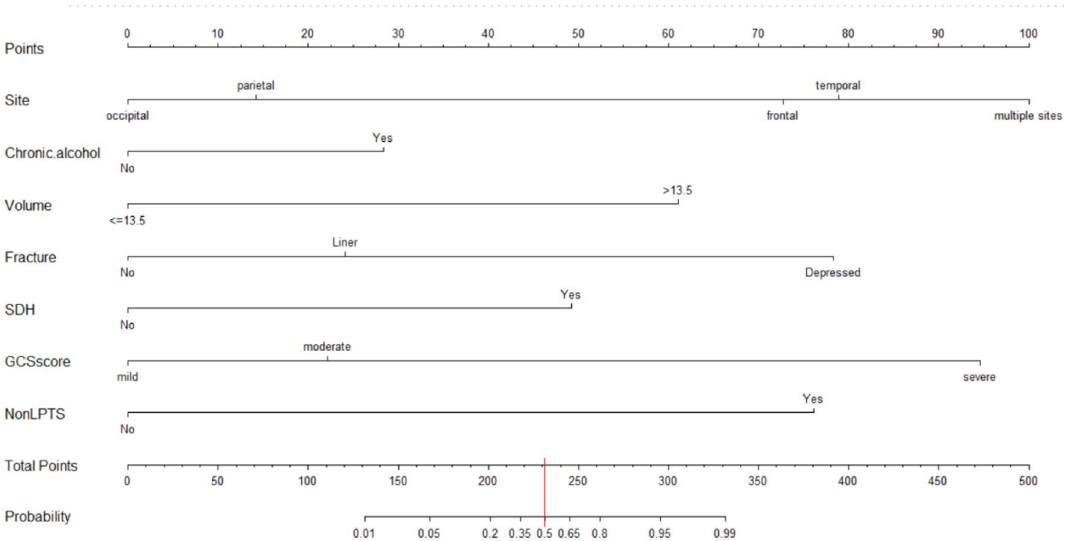
Figure 3. Multivariate analysis was performed for Site, Chronic alcohol use, Volume, Fracture, SDH, GCS score, and Non-LPTS. CI confidence interval, SDH subdural hematoma, GCS glasgow coma scale, LPTS late post-traumatic seizure.